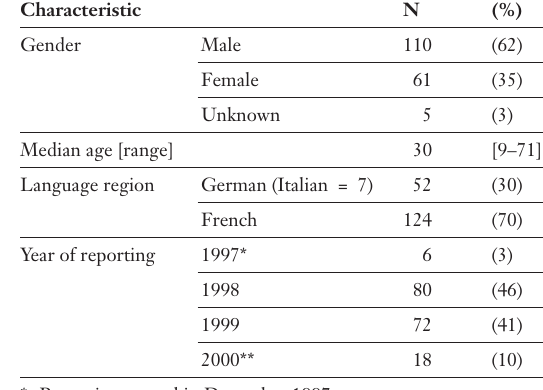
Mode of exposure of patients pre- scribed HIV-postex- posure prophylaxis in Switzerland,